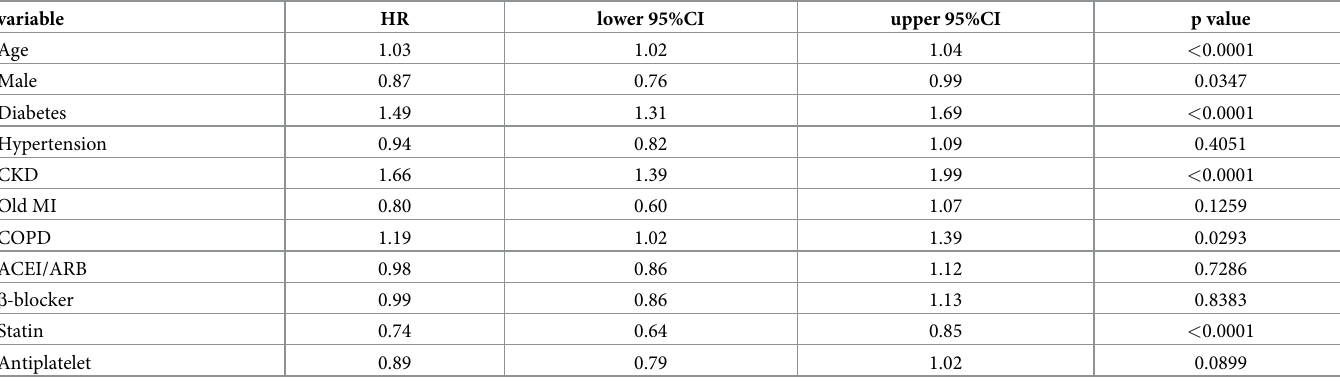
Table 6. Cox regression analysis in PCI group.